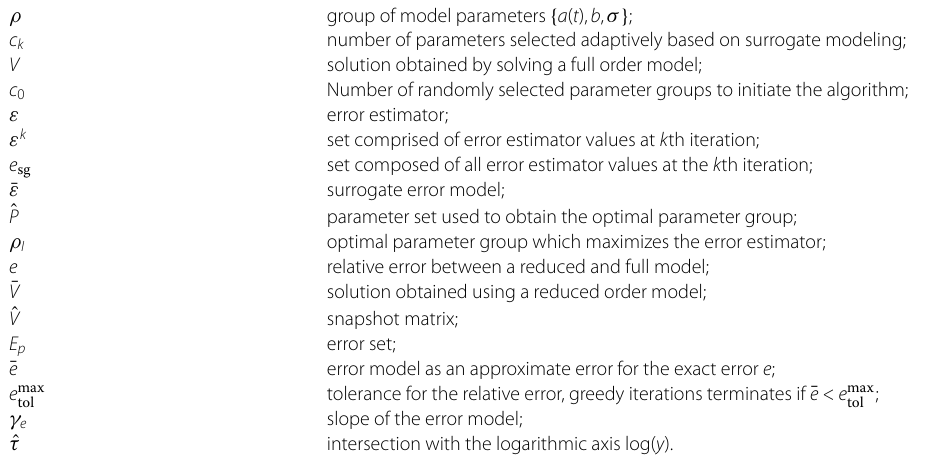
Table 2 List of symbols used in Algorithm